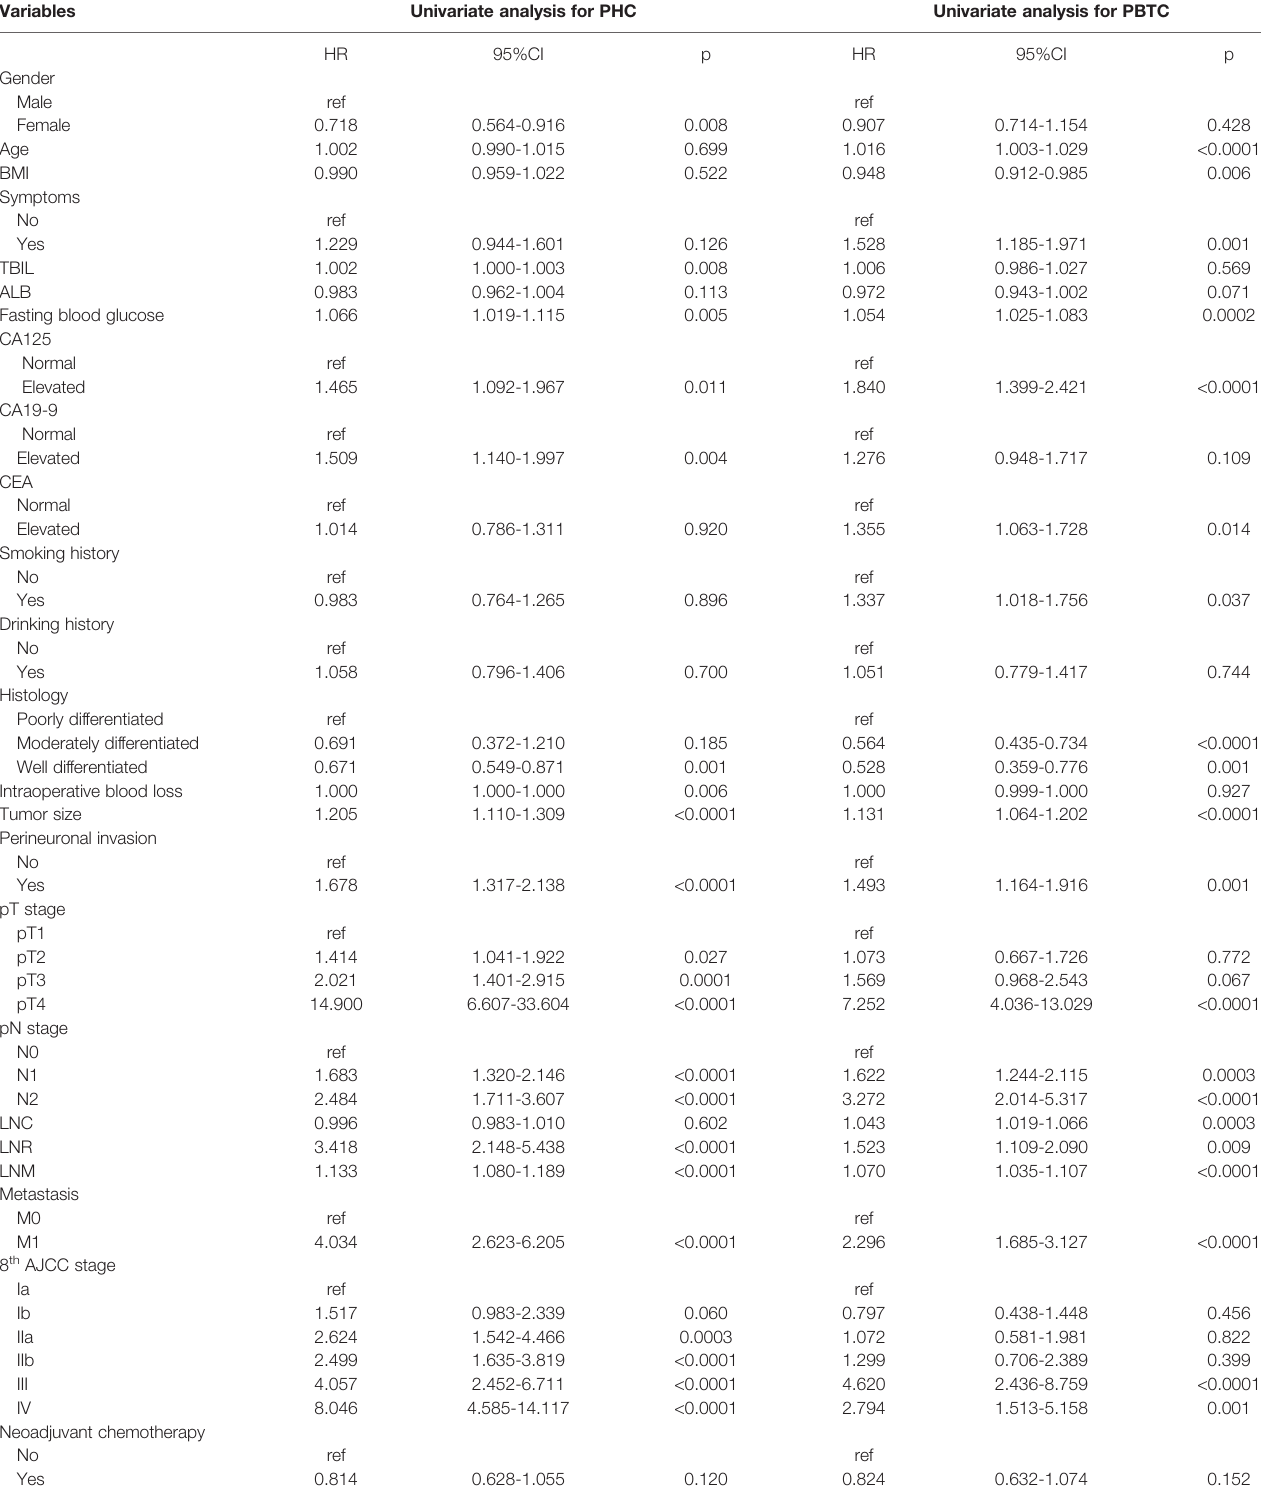
TABLE 3 | Univariate Cox regression analysis of prognostic factors in PHC and PBTC patients with curative-intent surgical